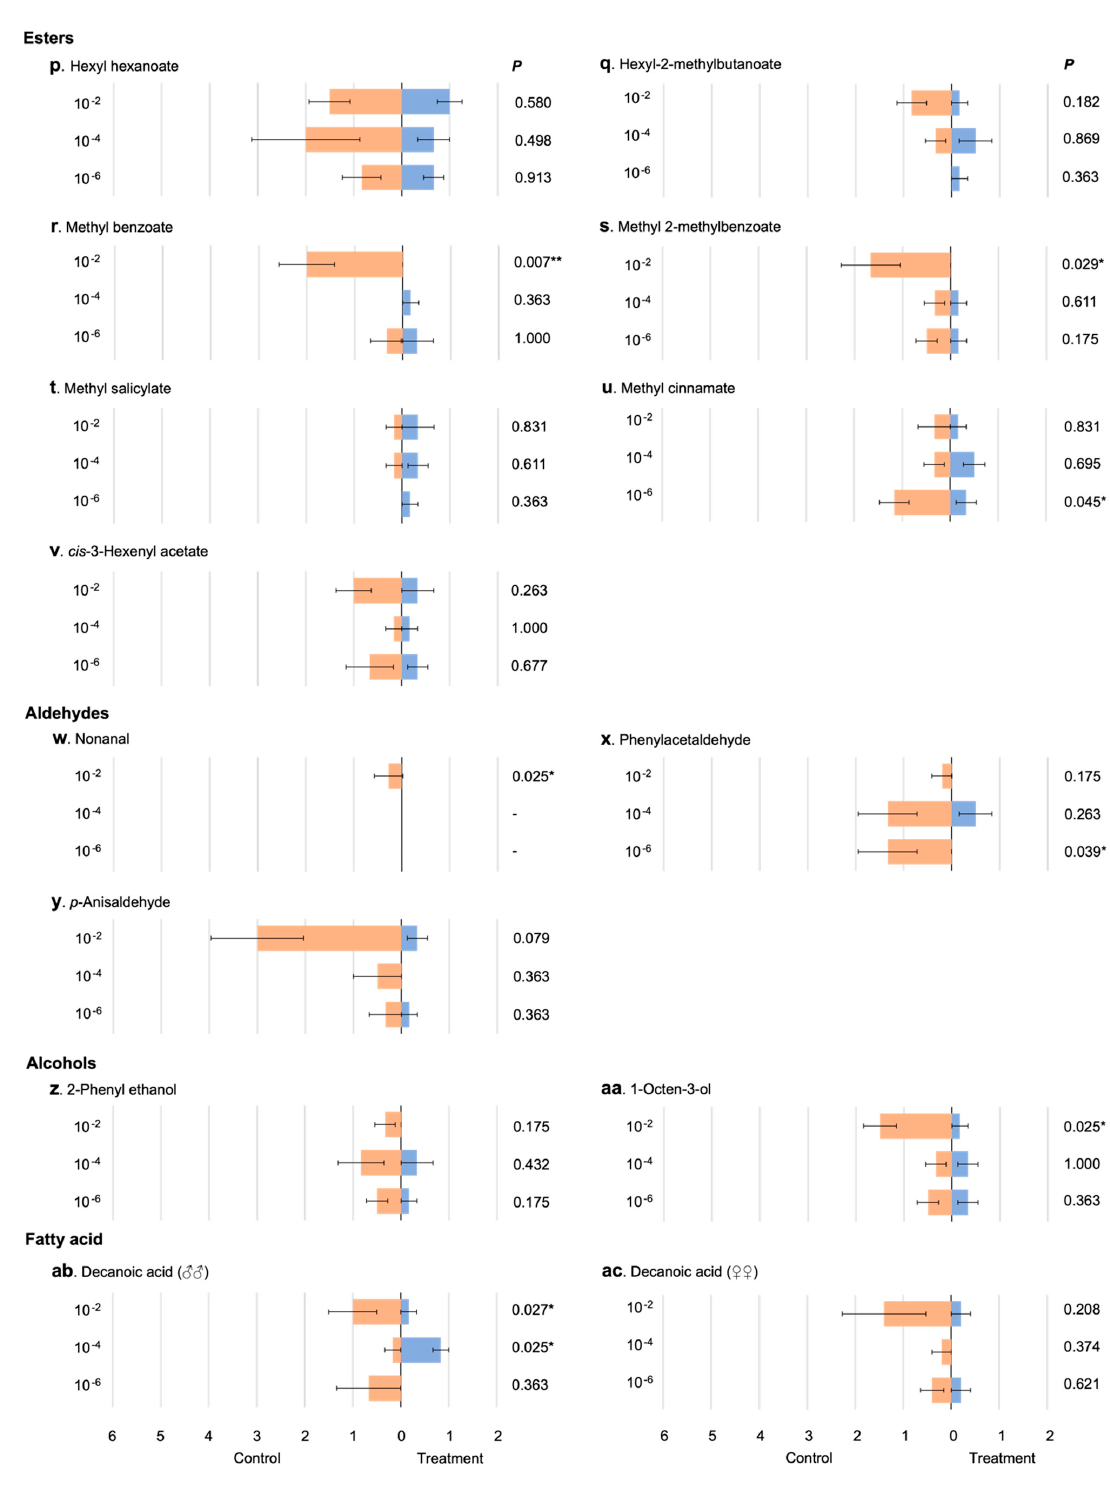
Figure 3. Responses of males (and females for decanoic acid) to different concentrations of chemical compounds. The orange and blue bars represent the mean number ( ± SE) of individuals trapped in the control and test chambers, respectively. The concentrations of the test compound are indicated on the left of each graph and the associated paired, two tailed t test p values are on the right (* p < 0.05; ** p < 0.01, *** p <